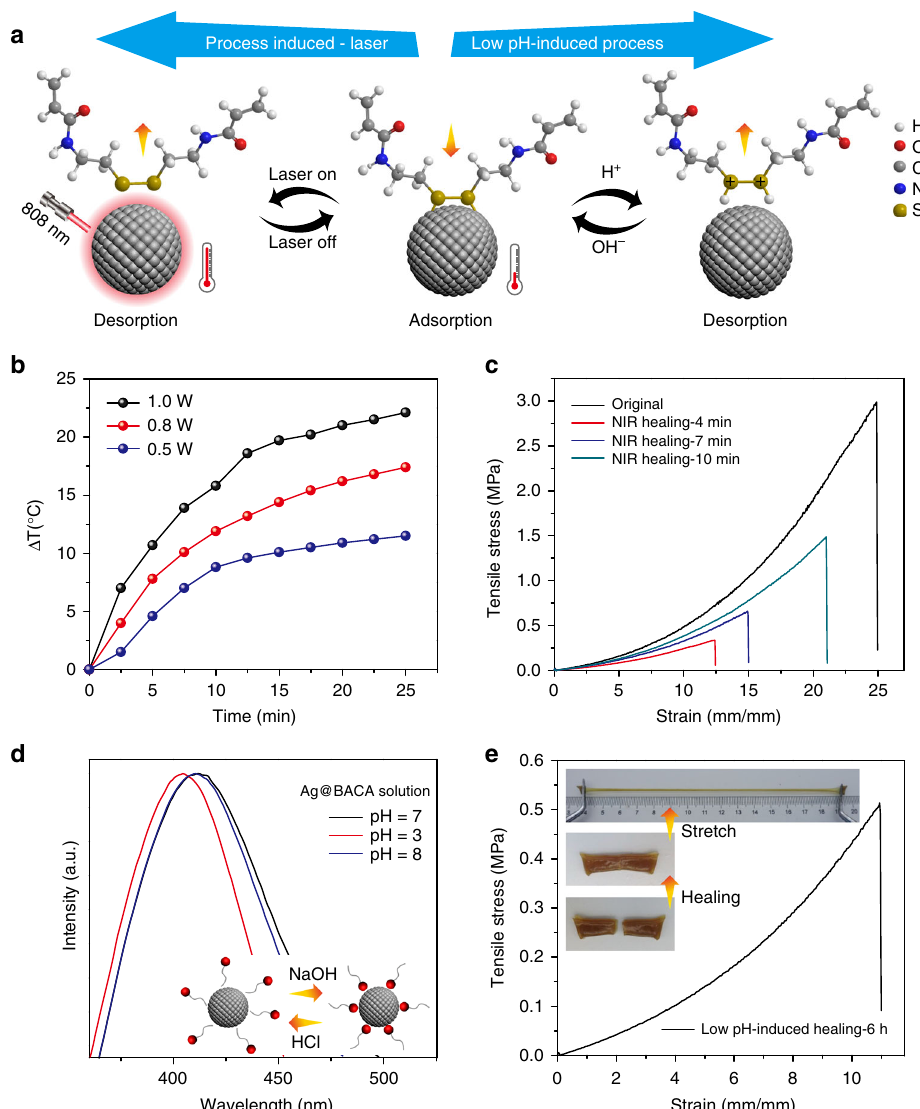
Fig. 5 Self-healing performance. a Schematic illustration of NIR laser-induced and pH-mediated self-healing mechanisms. b Time-dependent temperature changes of the SNPP hydrogel when exposed to NIR laser with various output power. c Tensile stress – strain curves of hydrogel piece relative to its original state and different healing times under NIR laser. d UV-vis spectra of Ag@BACA composite recorded to monitor the binding behavior between BACA and silver NPs in different pH solutions. The inset schemes illustrate the reversible binding of BACA and silver NPs with the regulation of pH. e Tensile stress – strain curves of the healed SNPP hydrogel piece through a pH mediated way. The inset optical images show high stretchability of the healed gel induced by the acid